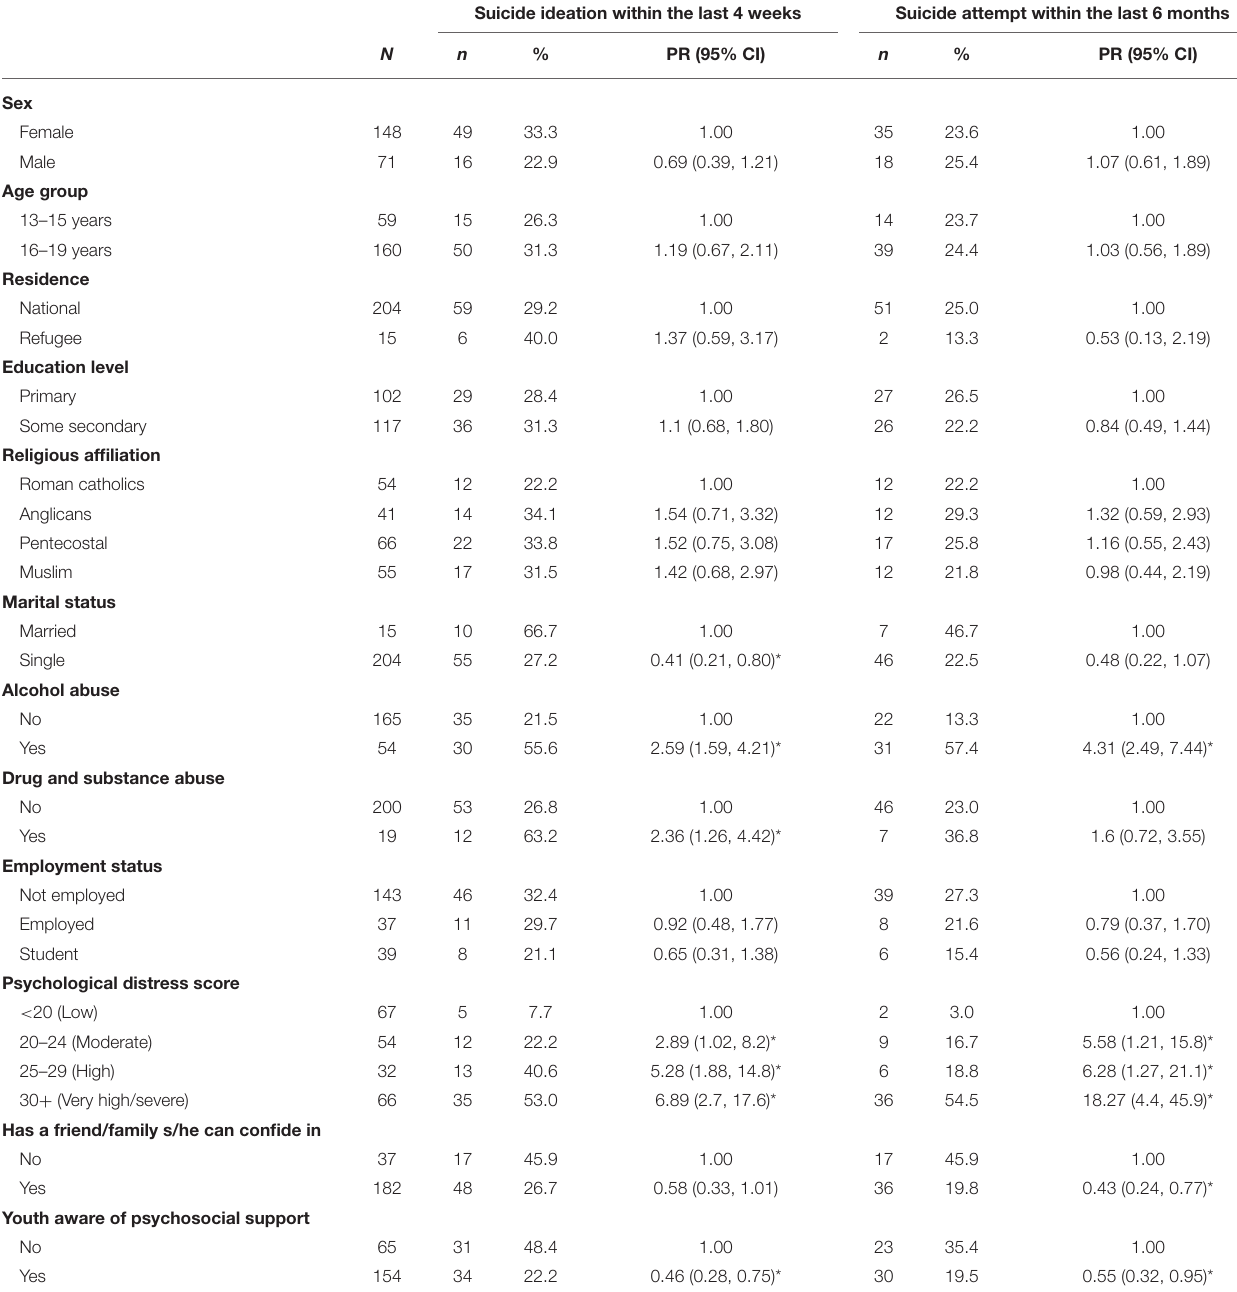
TABLE 2 | Univariate analysis of factors associated with suicide ideation and suicide attempt. Suicide ideation within the last 4 weeks Suicide attempt within the last 6